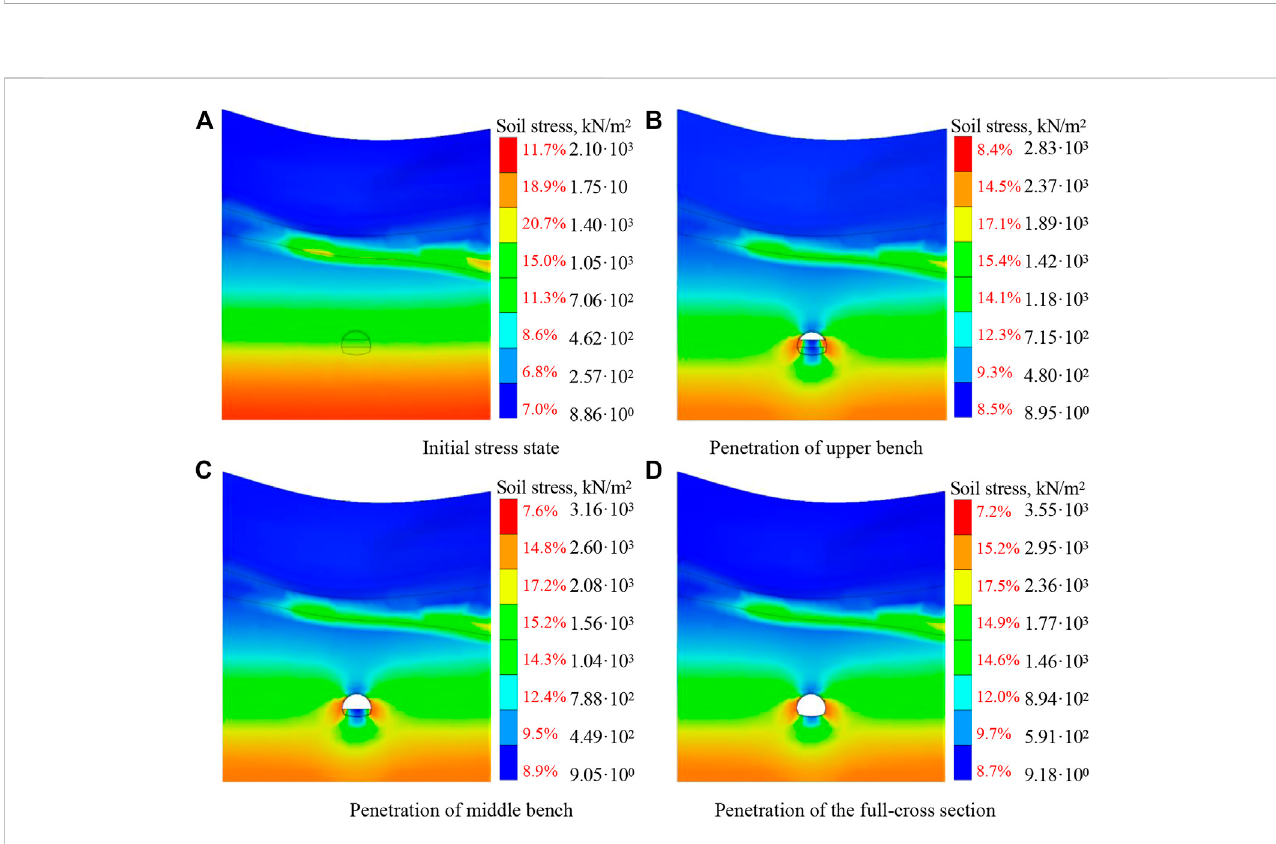
FIGURE 7 Stress of tunnel surrounding rock under three-bench method construction. (A) Initial stress state (B) Penetration of upper bench. (C) Penetration of middle bench (D) Penetration of the full-cross section.